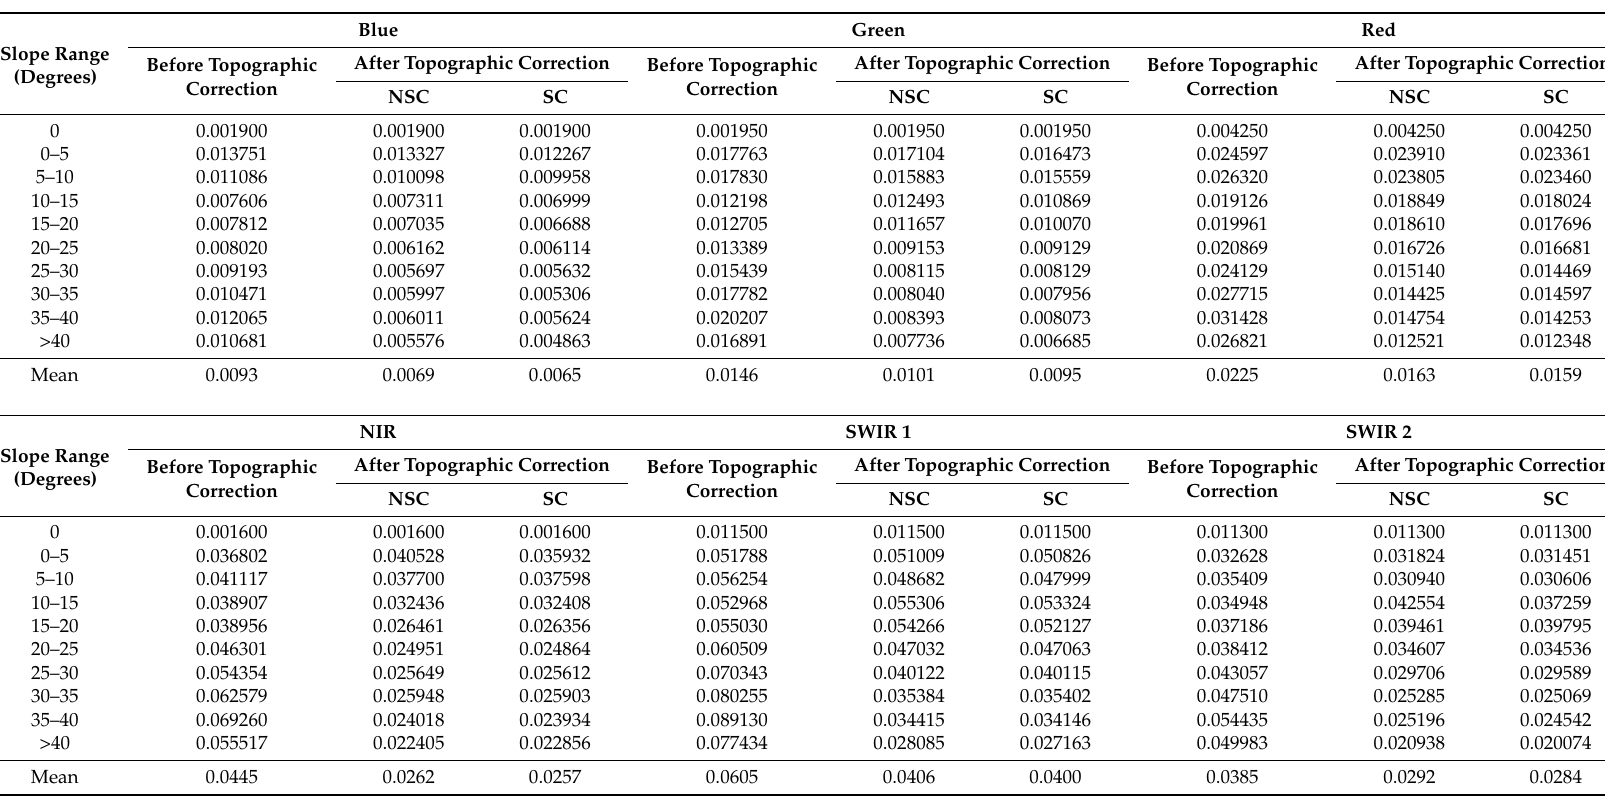
Table 1. Standard deviation values before and after applying the topographic correction by N-SC and SC for each band and each slope class of oak, pine, and mesophyll forest. Image: Landsat OLI from 7 March